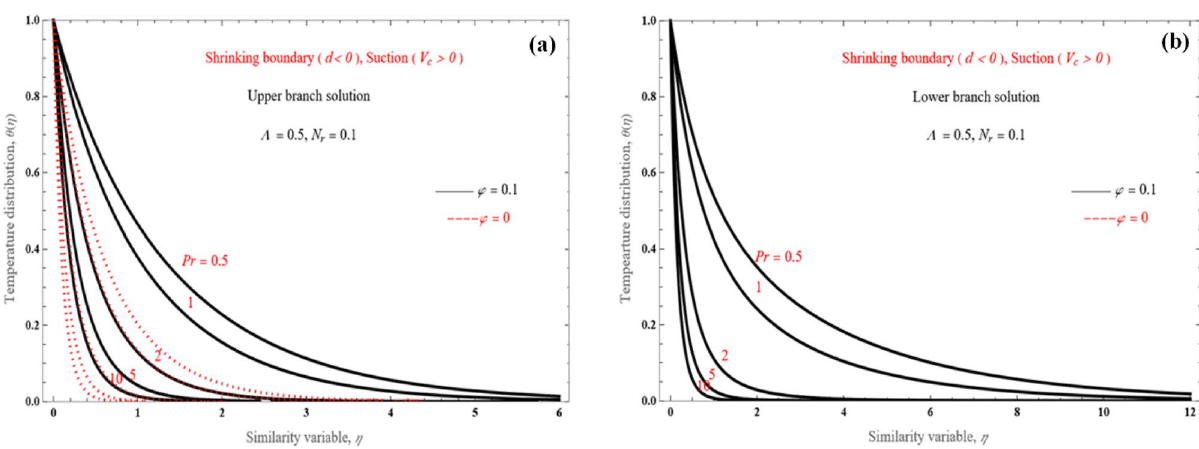
Figure 8. Temperature distribution for the ( a ) upper branch solution and ( b ) lower branch solution, for the shrinking sheet case and various value of